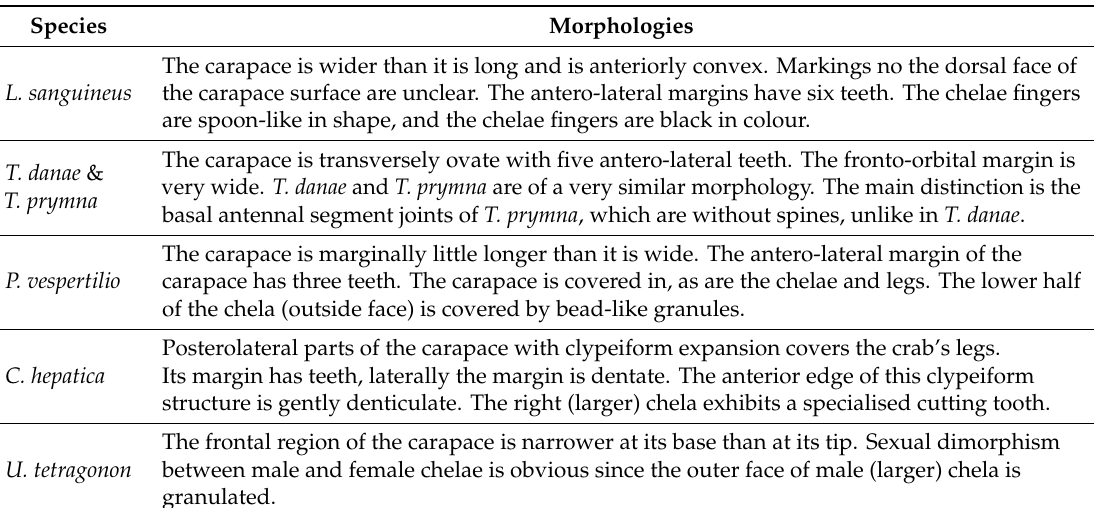
Figure 6. Representative examples of crabs collected from both Sombu beach and Liya beach: ( a ) L. sanguineus ; ( b ) Thalamita sp., here: T. danae ; ( c ) P. vespertilio ; ( d ) C. hepatica ; ( e ) U. tetragonon . Scale bars = 10 mm. Table 2. Additional morphological details for each